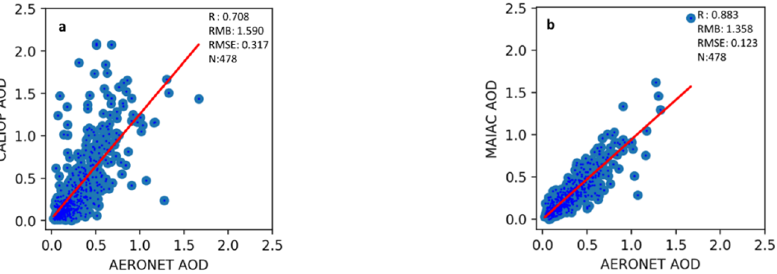
Figure 3. Scatterplot of ( a ) CALIOP AOD and ( b ) MAIAC AOD retrievals against collocated AERONET AOD. The solid red lines represent the linear regression for which the performance measures are shown in each plate: the Pearson’s correlation coefficient ( r ), the relative mean bias (RMB), and the RMSE.